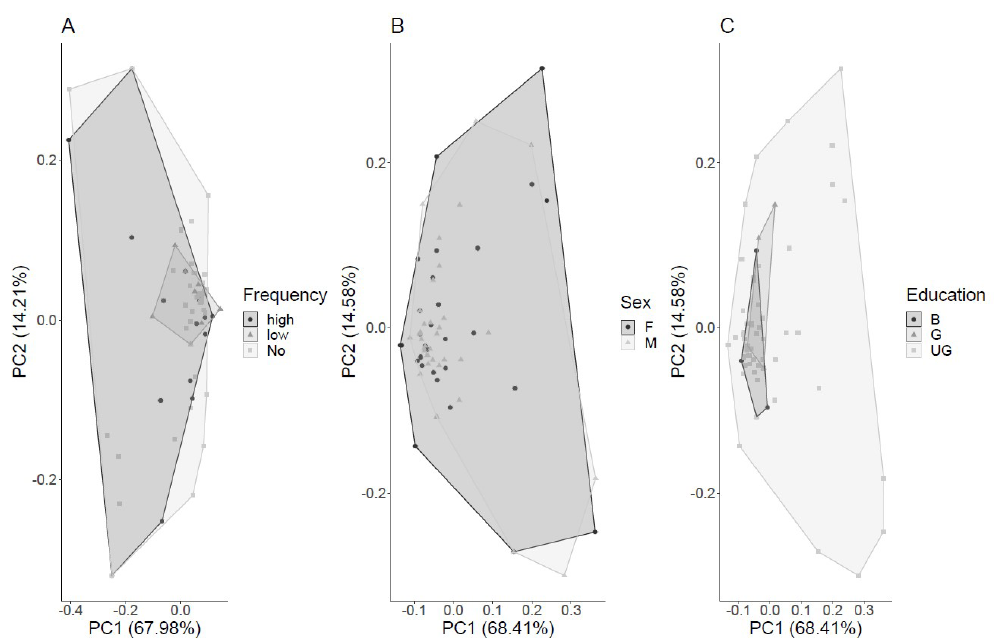
Figure 6. Principal Component Analysis regarding the correlation between people’s perception and chlorophyll-a concentration of all questions obtained in the in-situ experiment. The polygons represent the groups of people classified by the frequency of visits to aquatic environments (A), gender (B), and level of formal education (C). The frequency of visits was classified in: no visit, low frequency, and high frequency. Gender was classified into Male (M) or Female